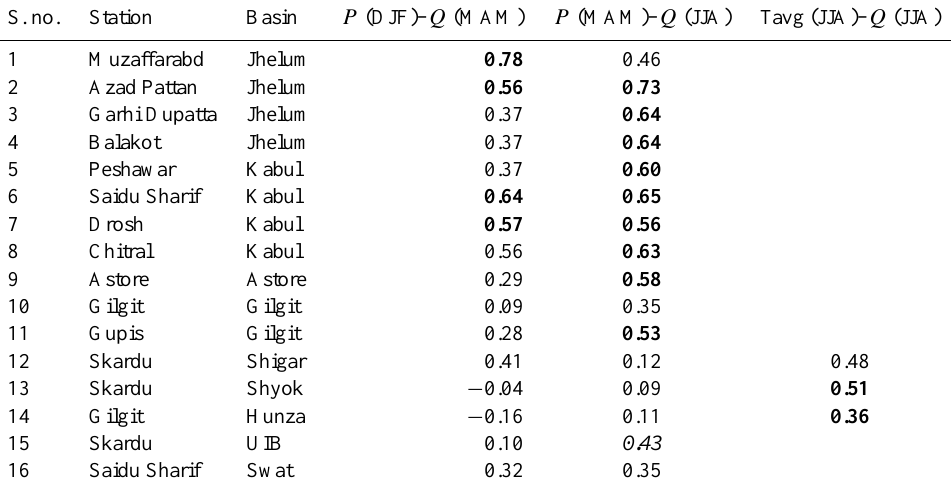
Table 11. Correlation coefficients between the long-term seasonal precipitation ( P ) or average temperature (Tavg), with the seasonal dis- charge ( Q ). Note: values significant at the 95% level are marked in